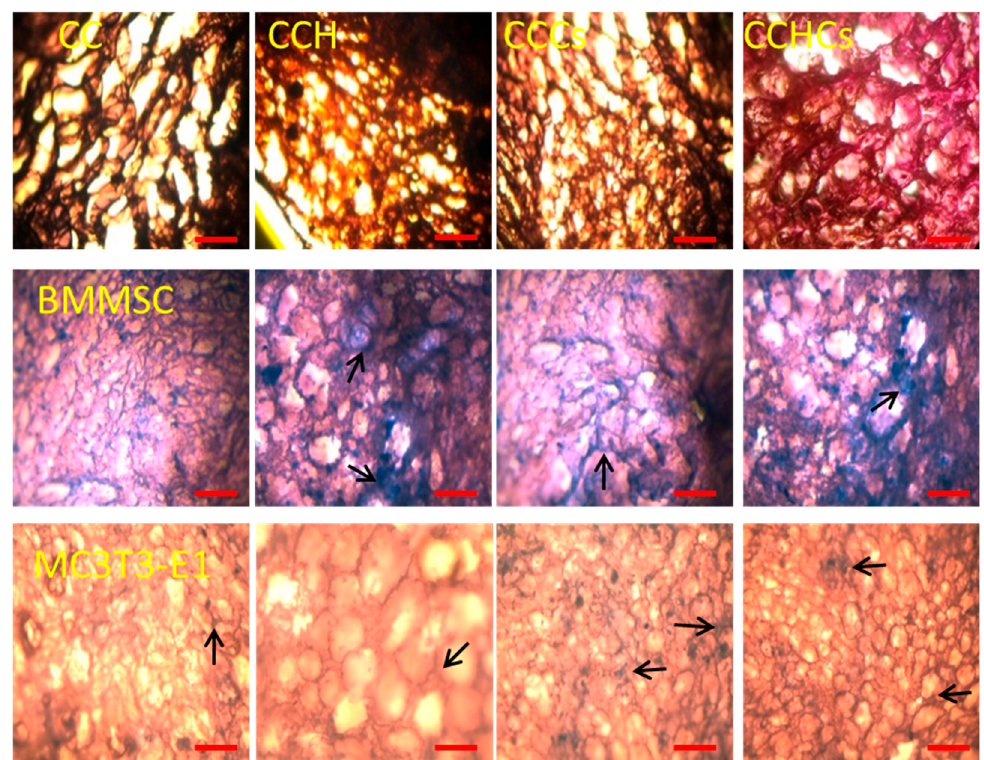
Figure 6. Hematoxylin-eosin staining of bone cells cultured on 3D matrices, 100× magnification. Cell nuclei are stained dark purple and 3D matrices pink. Scale bars: 200 µm. Arrows show stained cells. BMMSC: bone marrow-derived mesenchymal stem cells; MC3T3-E1, pre-osteoblast. CC: chitosan-collagen